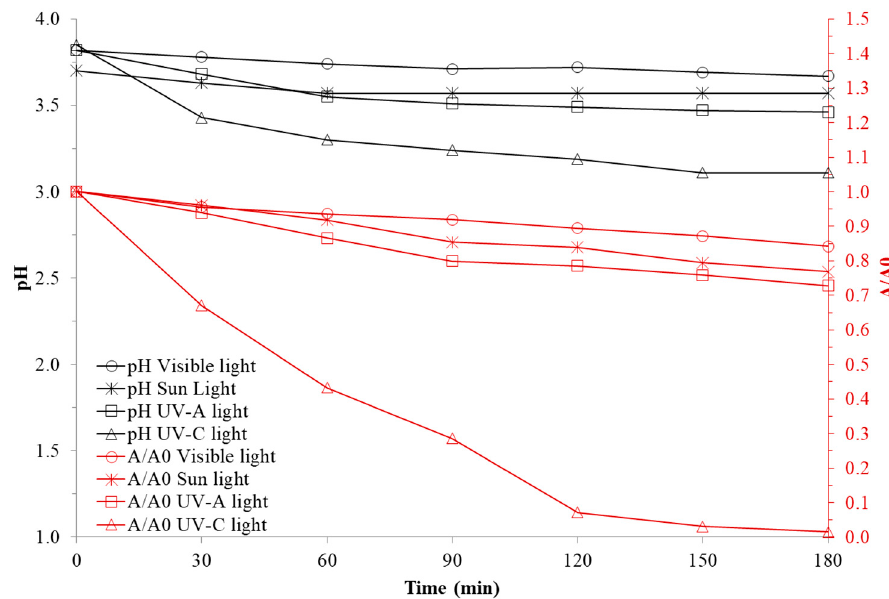
Figure 6. E ff ect of the type of light source on discoloration and pH ([H 2 O 2 ] = 10 mM, pH 0 = 3.8, Ilmenite loading = 0.7 g/L).